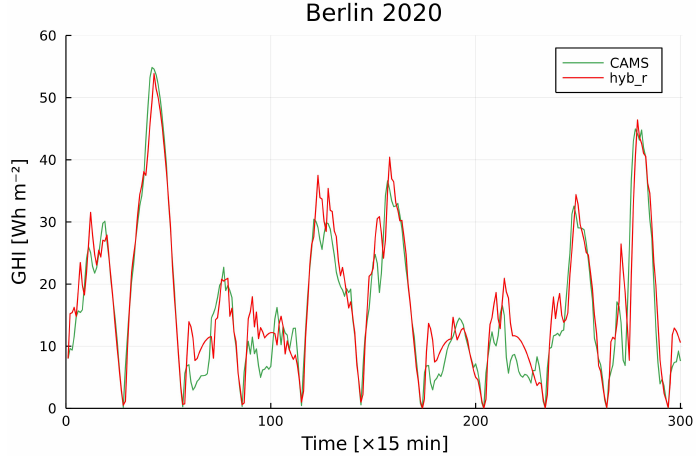
Figure 13. Comparison of actual daily GHI by CAMS (green) and predicted with a lead time of 15 min by the hybrid approach based on RMSE (red) for Berlin from 1 January 2020 to 11 January 2020.